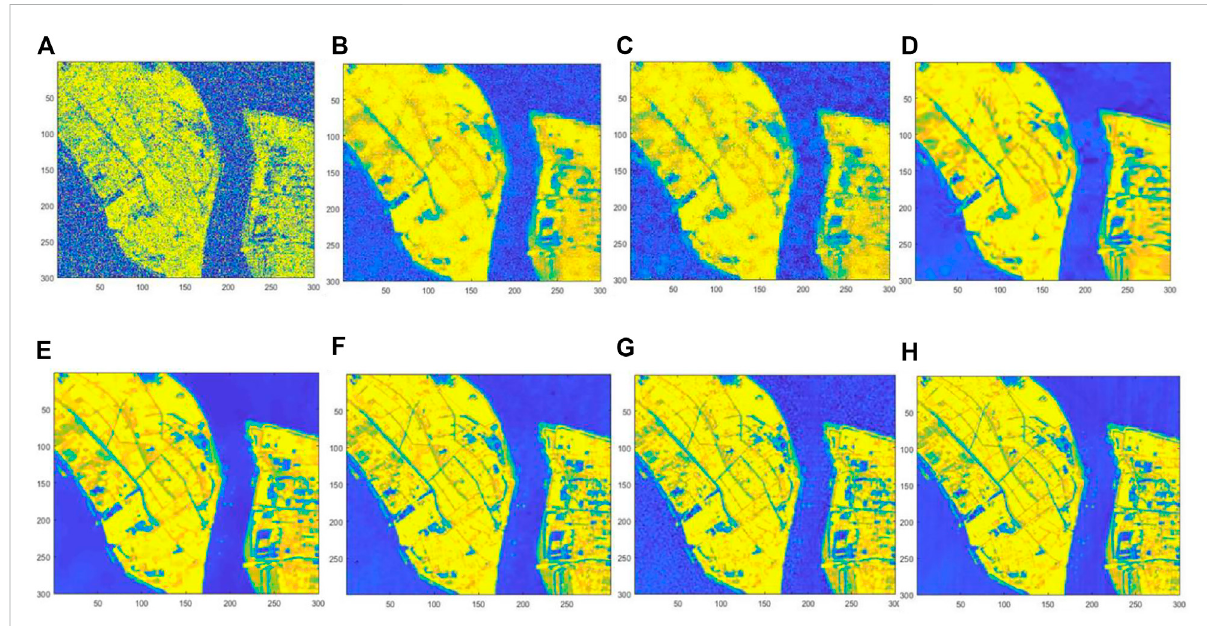
FIGURE 10 RestoredresultsofGF-5HSIdataofShanghaiCity: (A) Noisy, (B) L 1-2 SSTV, (C) QRNN3D, (D) LRTDGS, (E) SBNTRD, (F) LRTF- L 0 , (G) ANTRRM, (H)